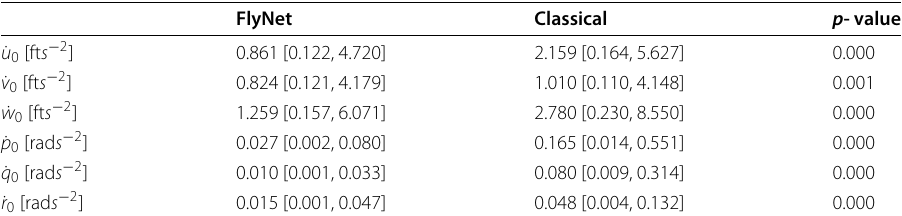
Table3 Average absolute initial trim offsets for training set ( N = 252) with 95% CI and p -value FlyNet